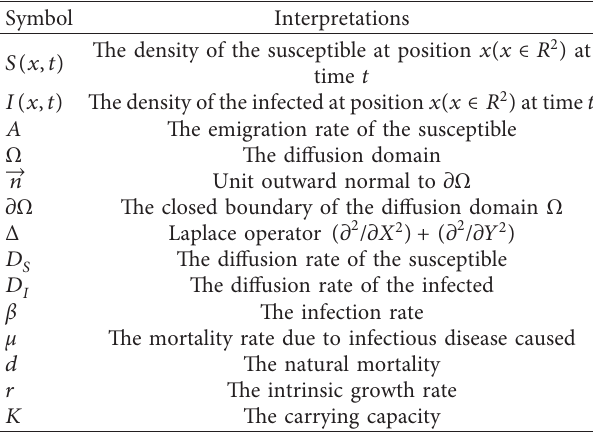
Table 1: Symbol descriptions of model (1). Symbol